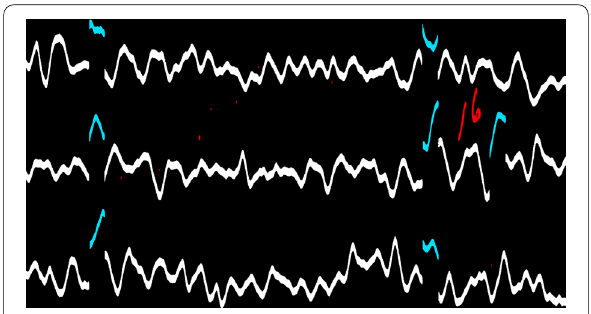
Fig. 1 An example of classification. The input image is processed to define objects that are categorized as main trace (white), time marks (cyan), or noise (red)